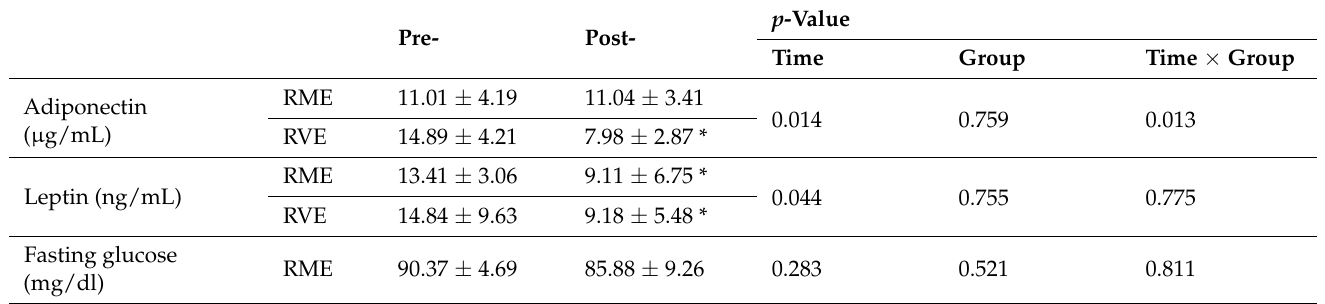
Figure 6. HDL (mg/dL). HDL, High-density lipoprotein.